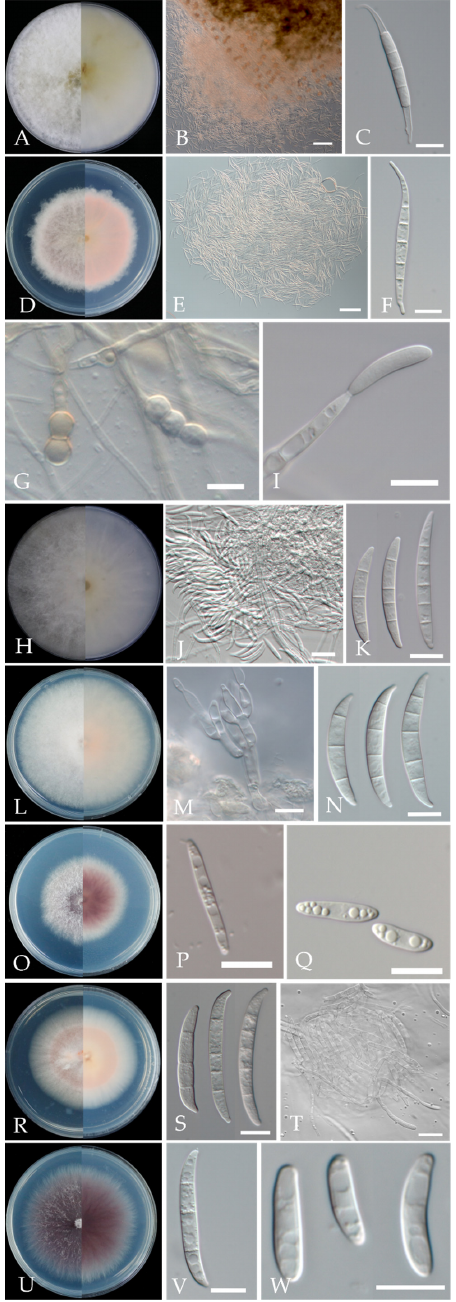
Figure 6. Morphological characteristics of Fusarium species isolated from cherry leaf spot. ( A ) Colony of F. compactum ; ( B ) Sporodochia of F. compactum on carnation leaf; ( C ) Macroconidia of F. compactum on CLA; ( D ) Colony of F. ipomoeae ; ( E ) Sporodochia of F. ipomoeae ; ( F ) Macroconidia of F. ipomoeae ; ( G ) Chlamydospores of F. ipomoeae ; ( H ) Colony of F. luffae ; ( I ) Conidiophore of F. luffae on aerial hyphae; ( J ) Sporodochia of F. luffae ; ( K ) Macroconidia of F. luffae ; ( L ) Colony of F. citri ; ( M ) Conidio- genous cells of F. citri formed on sporodochia; ( N ) Macroconidia of F. citri ; ( O ) Colony of F. nygamai ; ( P ) Macroconidia of F. nygamai ; ( Q ) Microconidia of F. nygamai ; ( R ) Colony of F. lateritium ; ( S ) Macro- conidia of F. lateritium ; ( T ) Sporodochia of F. lateritium ; ( U ) Colony of F. curvatum ; ( V ) Macroconidia of F. curvatum ; ( W ) Microconidia of F. curvatum . scale bar: ( A , C , D , F – I , K – S , U – W ) = 10 µ m; ( J , T ) = 20 µ m; ( B , E ) = 100 µ